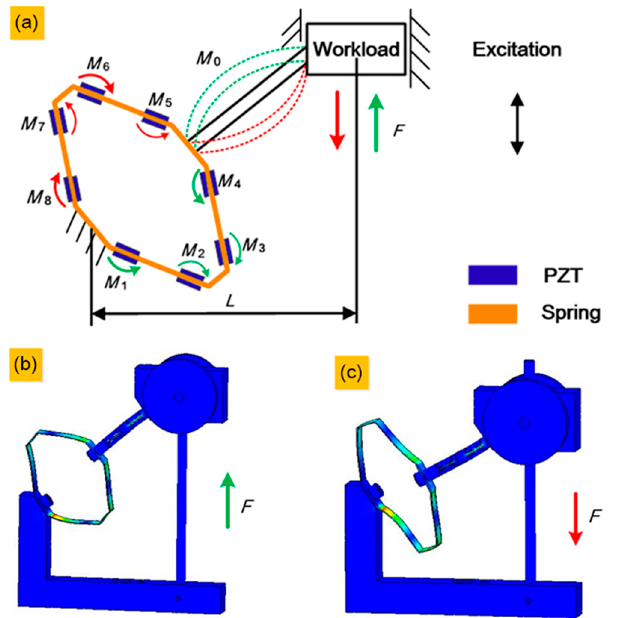
Figure 2. Force transmission in the generator: ( a ). Theoretical analysis. ( b ). Static simulation with vertical upward force. ( c ). Static simulation with vertical downward force.